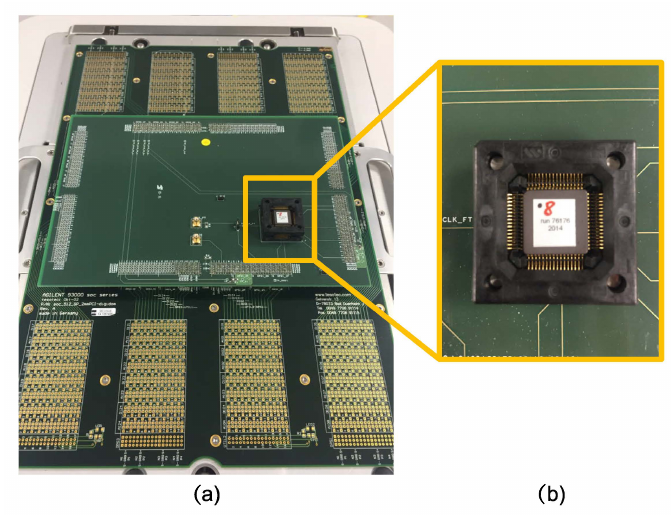
（ （ Figure 9. Experimental setup. ( a ) the ASIC test board. ( b ) one of the ASICs used to carry out the attacks on Trivium ciphers.